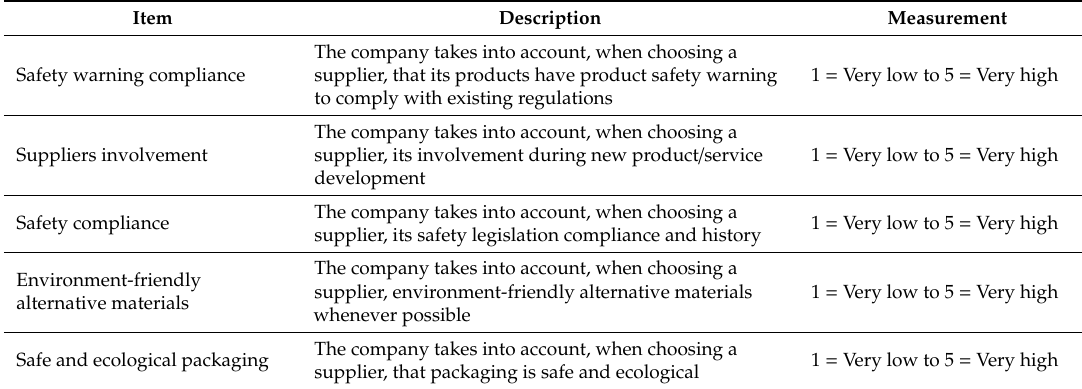
Table 2. Product Stewardship strategy items.